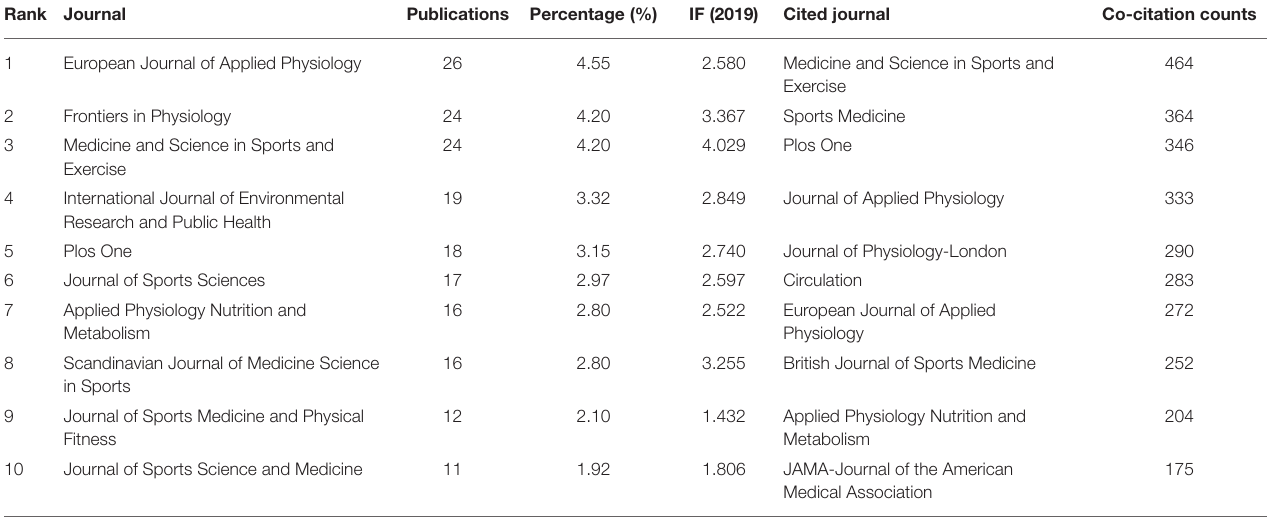
TABLE 2 | Ranking of top 10 journals and co-cited journals involved in the HIIT-HP